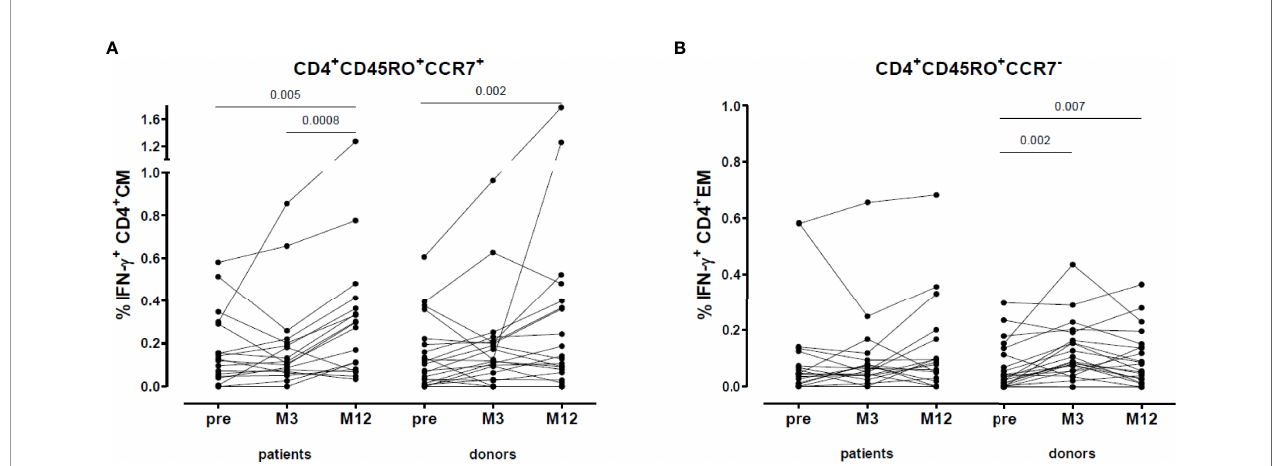
FIGURE 6 | VZV-reactive T cell response: CD4 + central and effector memory. (A) Percentage VZV-speci fi c IFN- g producing CD4 + central memory cells. (B) Percentage VZV-speci fi c IFN- g producing CD4 + effector memory